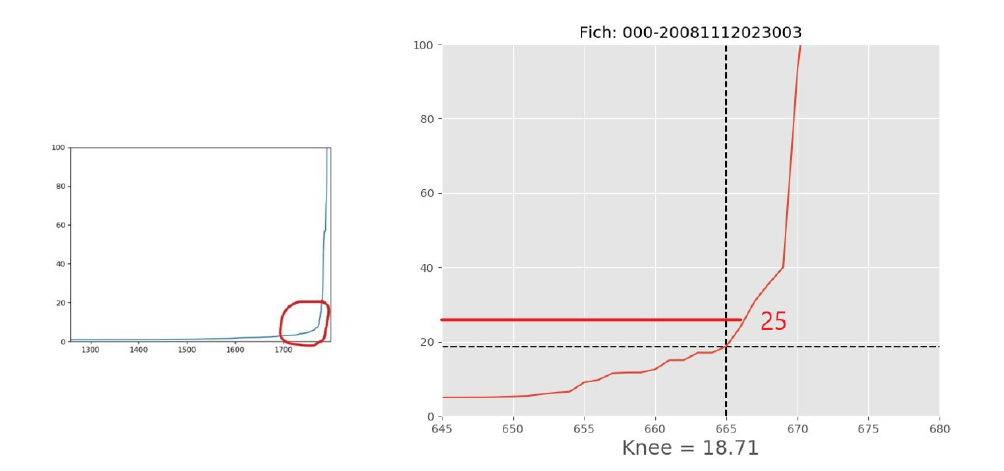
Figure 3. DBSCAN knee visualisation